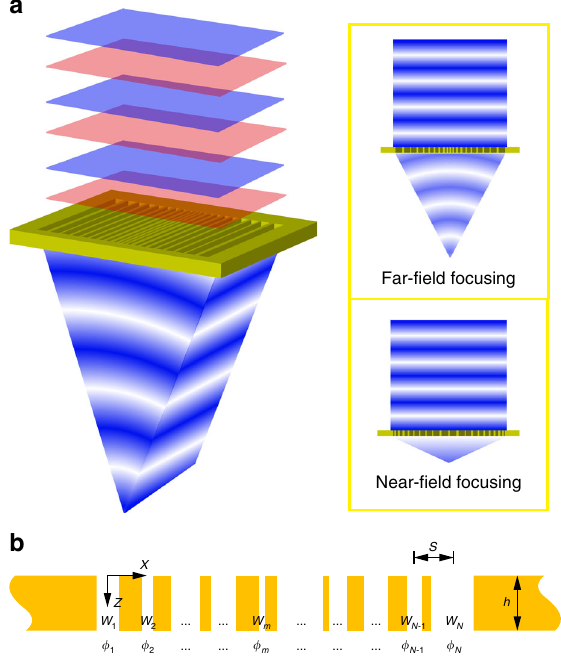
Fig. 1 Metasurface-based acoustic lens. a Convergence of acoustic energy by the metasurface lens after a normally incident plane wave transmits through it. Through proper design of the individual unit elements and their arrangement, different focusing schemes can be achieved, as presented in the insets. b Schematic representation of the acoustic metasurface lens. It consists of N slits that are periodically perforated in a thin plate with a spacing of s and a depth of h . The width and phase shift of the m th slit are denoted by w m and ϕ m ,